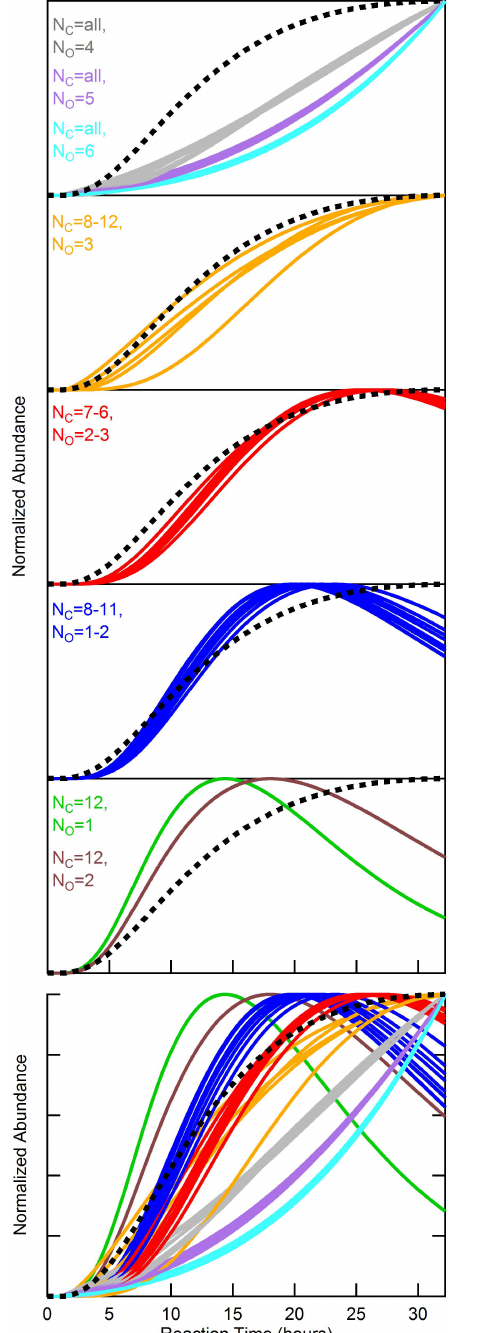
Fig. 6. Simulated time-evolution of each SOM species (i.e. N C / N O pair) during the low-NO x photooxidation of dodecane. Species that exhibit a similar temporal dependence have been grouped into “clusters” and are shown in individual panels with the same color; the N C and N O of the species that belong to each “cluster” for each panel are indicated as labels. Each species profile has been normal- ized to its maximum concentration. For reference, the dashed black trace in each panel shows the time-evolution of the normalized total SOA mass. The bottom panel shows all traces together so that the time-evolution of the various clusters can be compared.